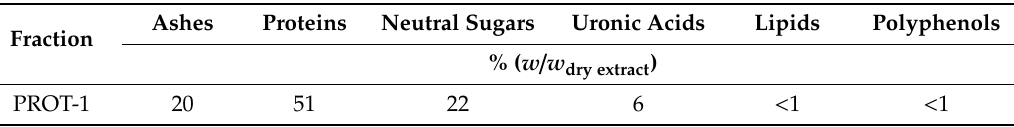
Table 1. Biochemical composition of the PROT-1 fraction.